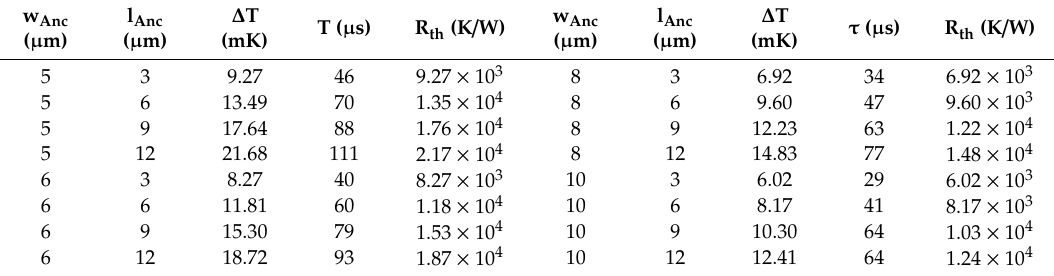
Figure 14. Calculated transient responses of the detectors with vacuum encapsulation and non-vacuum encapsulation. The anchor dimension was set as 5 × 12 μ m.